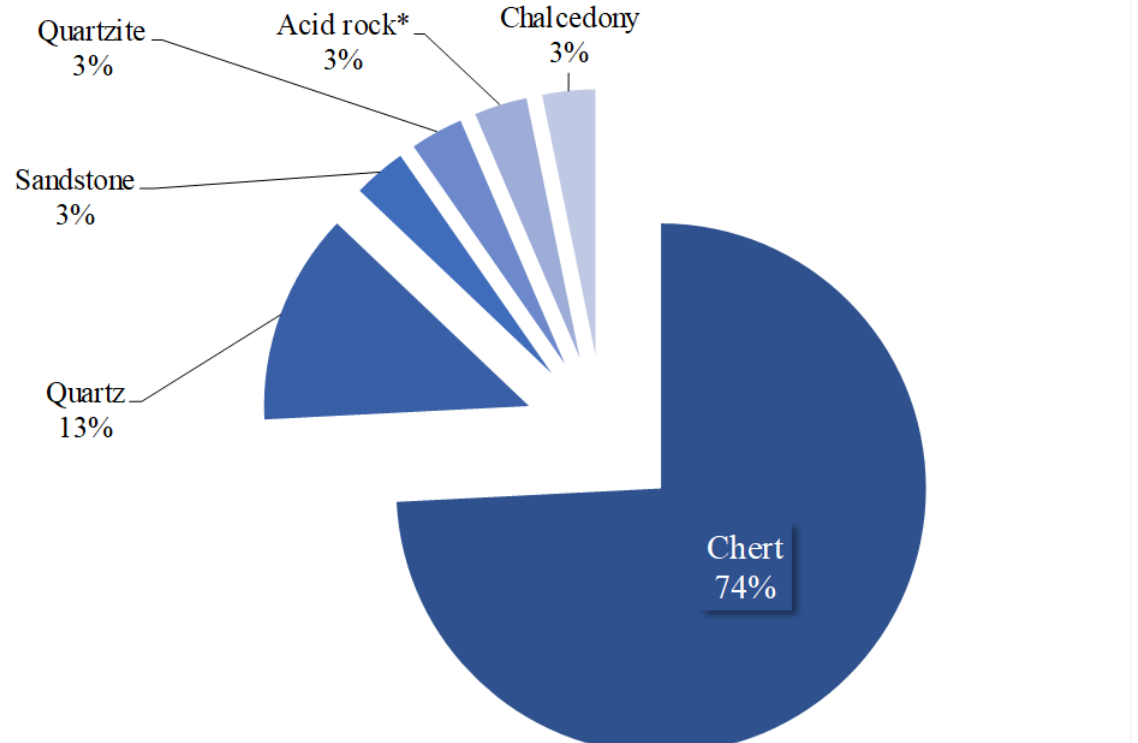
Figure 4. Raw materials recognized among FPs in south Brazil (based on Table 1). *Rhyolite, rhyodacite or basaltic- andesite. “Sandstone” refers to silicified